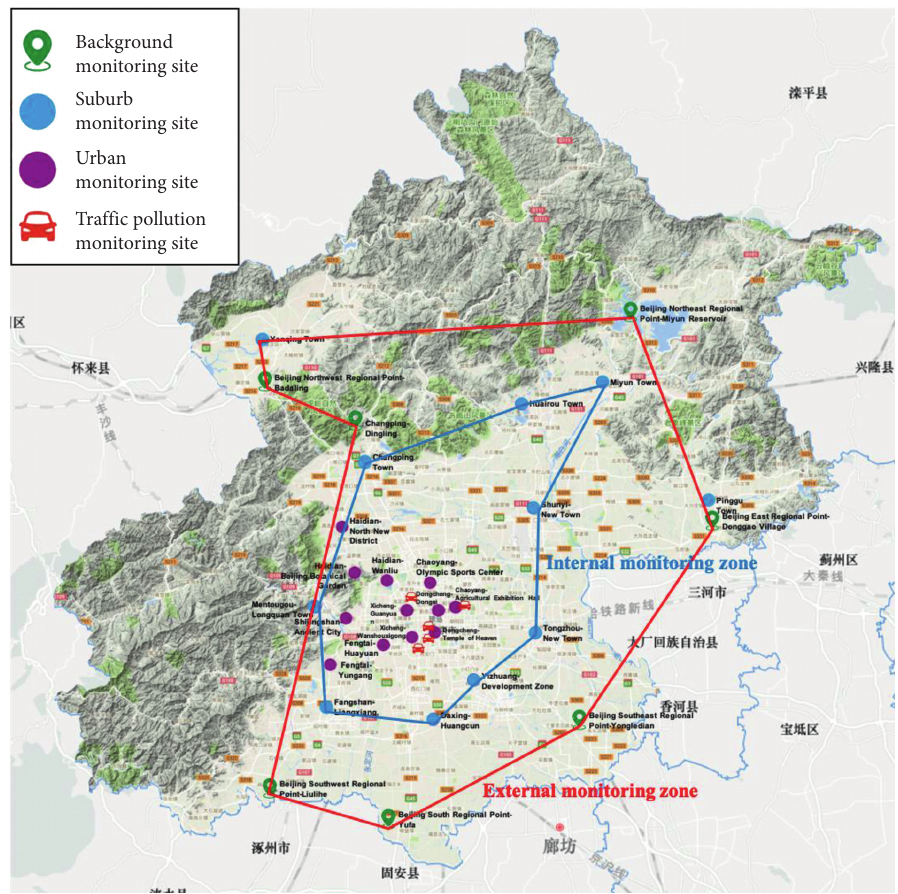
Figure 2: The composition of the external input pollutant monitoring zone. Table 1: External pollutant identification